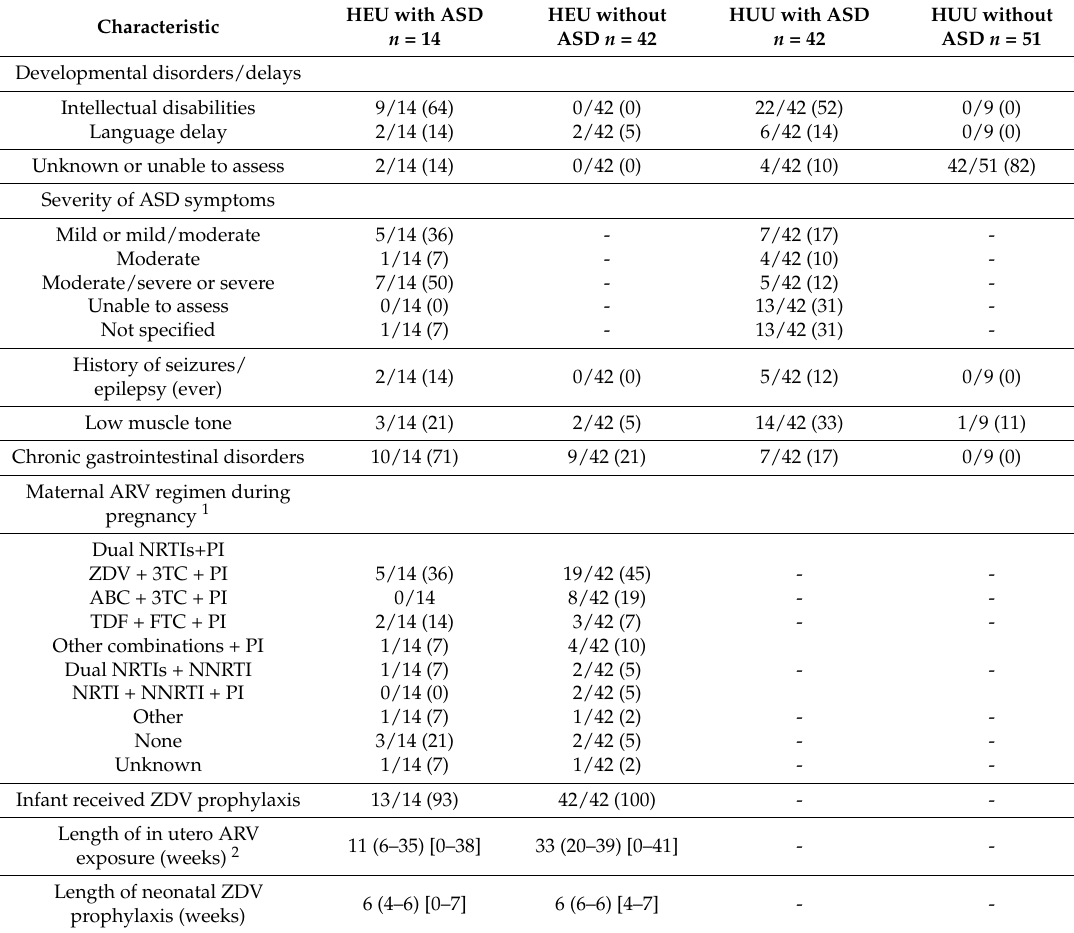
Table 2. Clinical characteristics of matched study participants (cases and